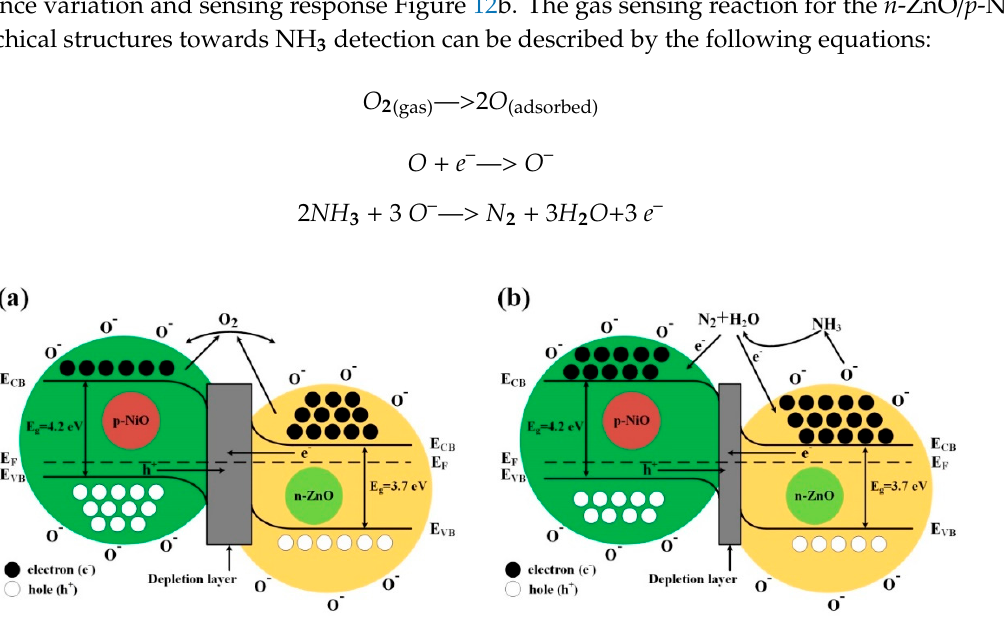
Figure 12. Proposed band structure model for 3D n -ZnO / p -NiO heterojunction ( a ) in air and ( b ) in NH 3 . (E CB , lower level of conduction band; E F , Fermi level; E VB , upper level of valence band).